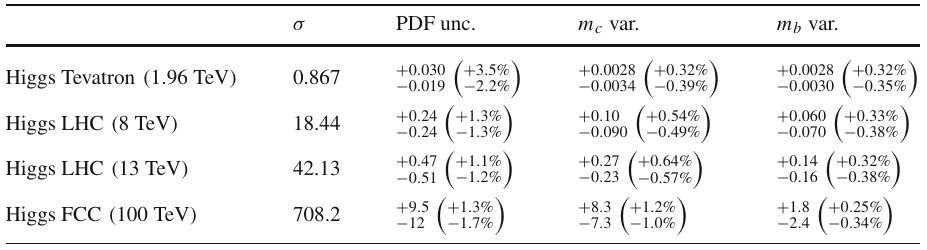
Table 9 Predictions for tt cross sections (in pb), obtained with the NNLO MSHT20 parton sets. The PDF uncertainties and m c and m b variations are shown, where the m c variation corresponds to ± 0 . 15 GeV and the m b variation corresponds to ± 0 . 5 GeV